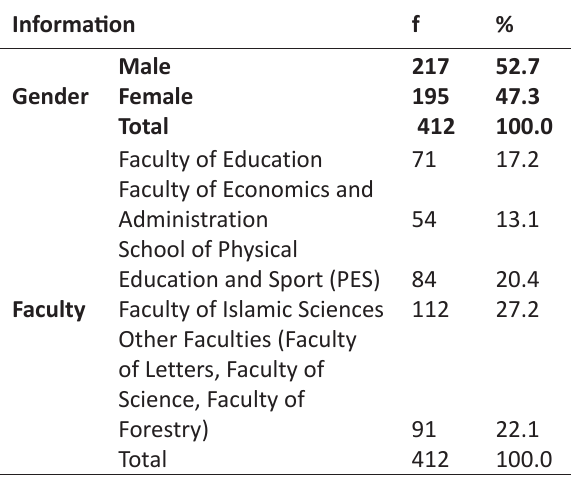
Table 1. Demographic information of the